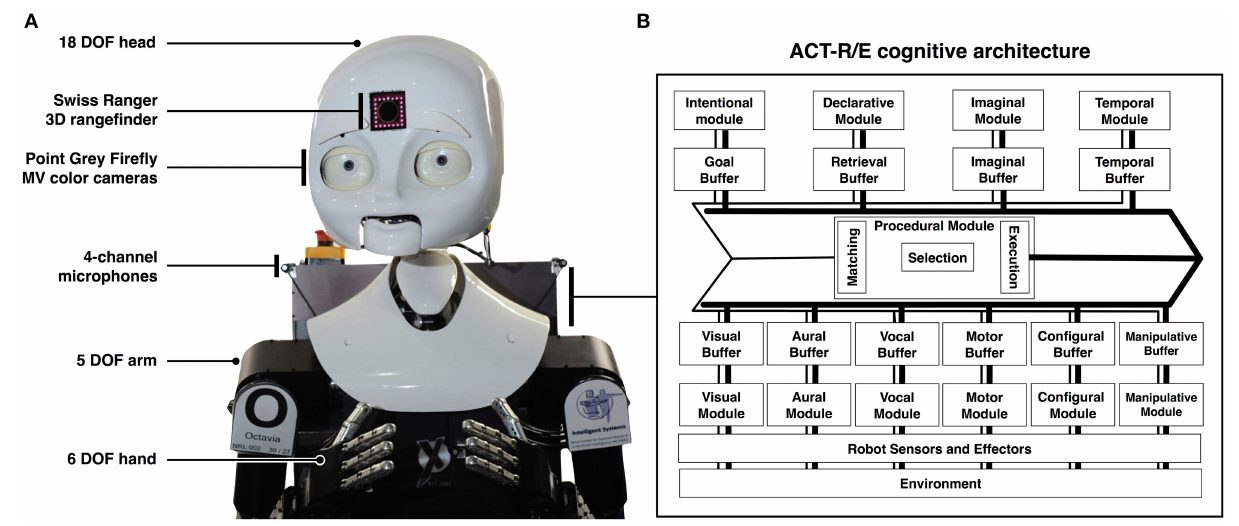
FIGURE 2 | The robotic implementation of the ACT-R/E cognitive. (A) depicts the MDS (mobile, dexterous, social) robot in use in our lab, and shows its various sensors and effectors. (B) provides the details of the ACT-R/E cognitive architecture ( Trafton et al., 2013). The architecture is an embodied extension of ACT-R (Anderson, 2007), and it interfaces the robot’s sensory apparatus. ACT-R/E is composed of multiple modules that mimic components of human cognition. For example, it includes modules for maintaining goals, storing declarative memories, processing visual, and auditory input, and issuing motor commands. Each module is paired with a buffer that limits the capacity that the system can process at once, and accordingly implements a processing bottleneck characteristic of human cognition. Computational implementations of cognitive processes, such as the event segmentation system we present, are developed in ACT-R/E by constructing procedural memory representations that are executed under pre-specified conditions, and which retrieve information from or else modify the contents of the system’s various buffers. In the diagram, the thin lines depict the pipeline for retrieval from the contents of the buffers and the thick lines depict the pipeline for modifying the contents of the